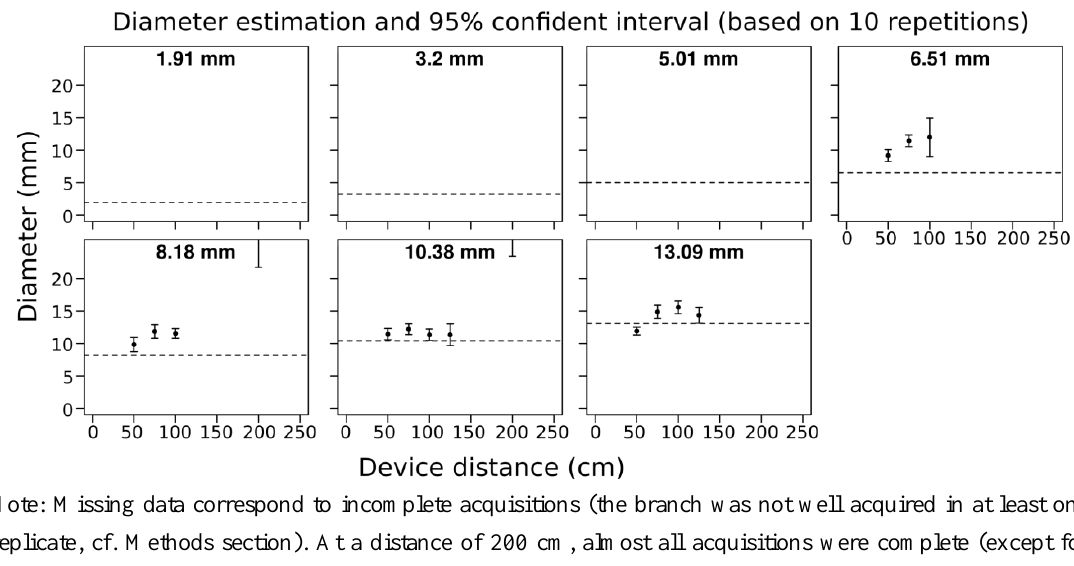
Figure 2. Threshold for diameter detection and accuracy of diameter measurement as a function of distance from branches of Salix of various diameters (shown in bold at center, top of each panel) measured from 3D images captured using the Asus Xtion Pro Live. Whiskers show 95% confidence intervals † for the mean, calculated from 10 replicate